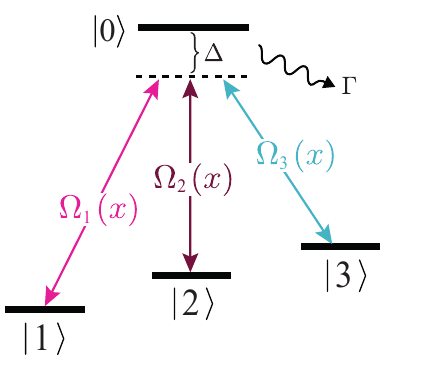
Figure 2: Representation of a set of Rabi frequencies Ω = ( Ω the polar and azimuthal angles θ and φ